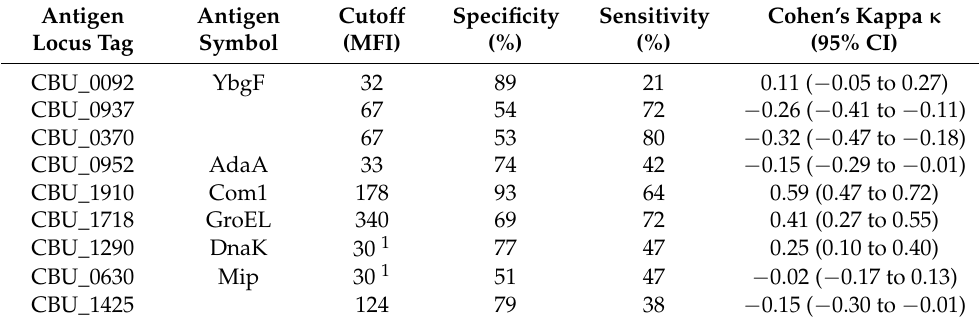
Table 3. Performance of nine C. burnetii antigens measured in 76 reference samples with positive, and 91 with negative, C. burnetii serostatuses. Quantitative measurement values were dichotomized using the given cutoff (maximum value of the Youden’s index) to calculate assay specificity, sensitivity, and agreement